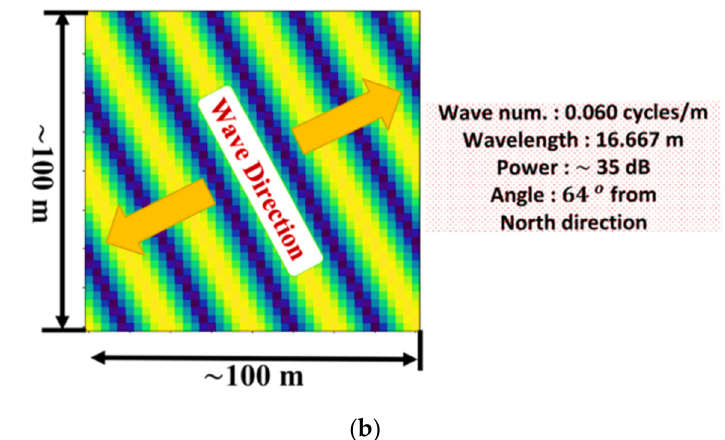
Figure 14. ( a ) A Fourier image demonstrating the wave direction (0.06 cycles/m) of LWA-1 with angles about 60 degrees eastward (northeast–southwest) from the north–south direction as well as its IFT in ( b ).